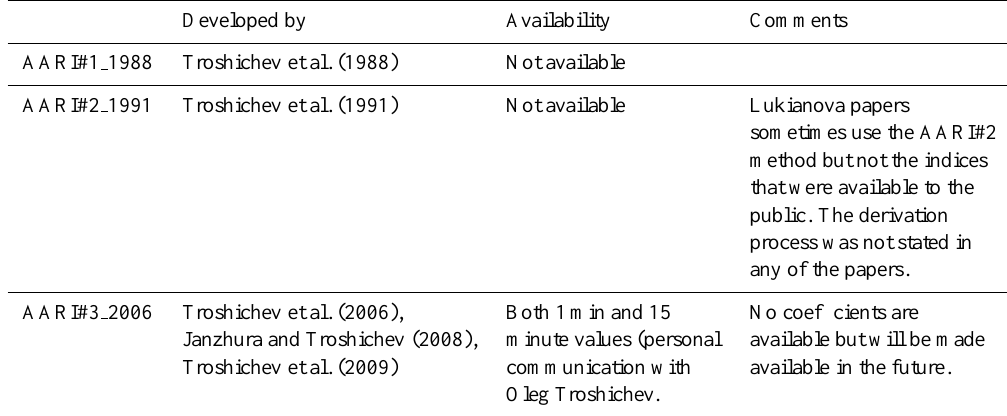
Table 3. Characteristics of the PCS